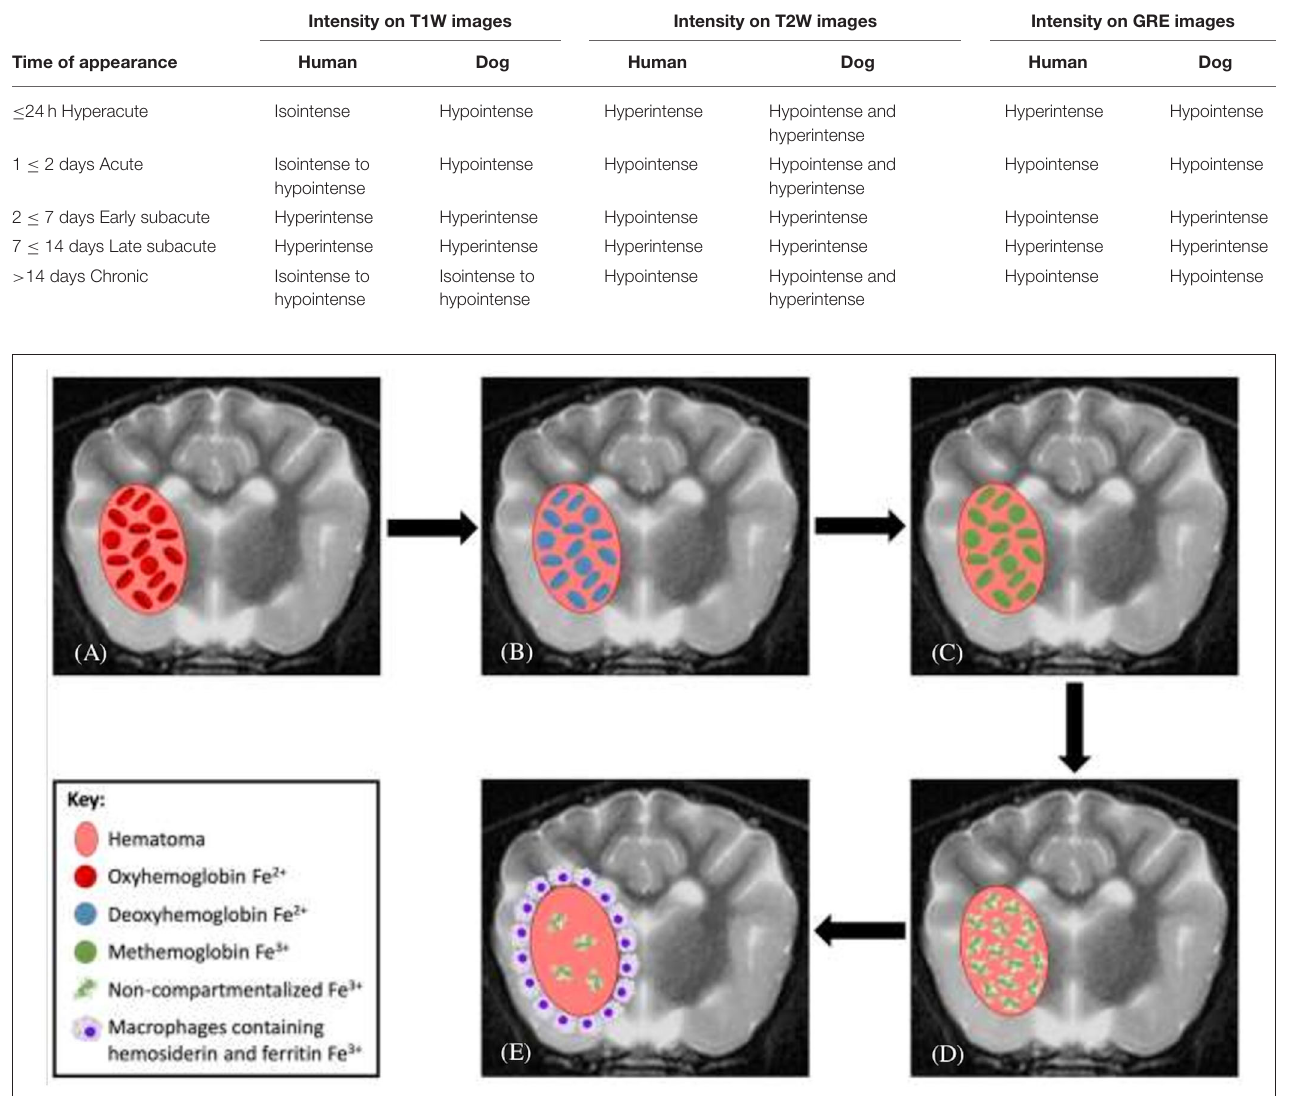
FIGURE 1 | Evolution of intraparenchymal hemorrhage on magnetic resonance imaging. (A) In the earliest stage of acute hematomas, blood is still oxygenated within intact red blood cells (RBCs). (B) Rapid deoxygenation occurs, first at the periphery and then throughout the hematoma, but the RBCs remain intact. (C) As the lesion undergoes oxidation, the peripheral hemoglobin within intact RBCs forms methemoglobin. (D) This oxidation process and conversion to methemoglobin occur throughout the hematoma and subsequently the RBCs lyse. (E) As free methemoglobin is formed, hemosiderin and other iron storage forms are deposited within macrophages in the adjacent brain parenchyma. Eventually, the lesion contains no intact RBCs, and methemoglobin is resorbed or metabolized, leaving only a collapsed cleft lined by hemosiderin and ferritin without any notable central